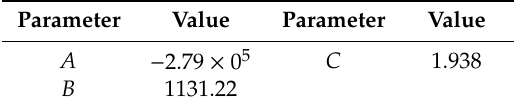
Table 4. Fitted parameters of the final crystal suspension